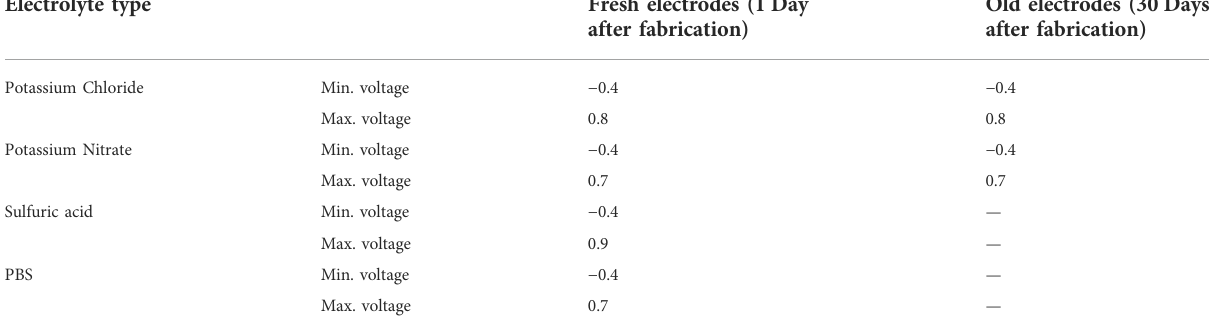
Old electrodes (30 Days after